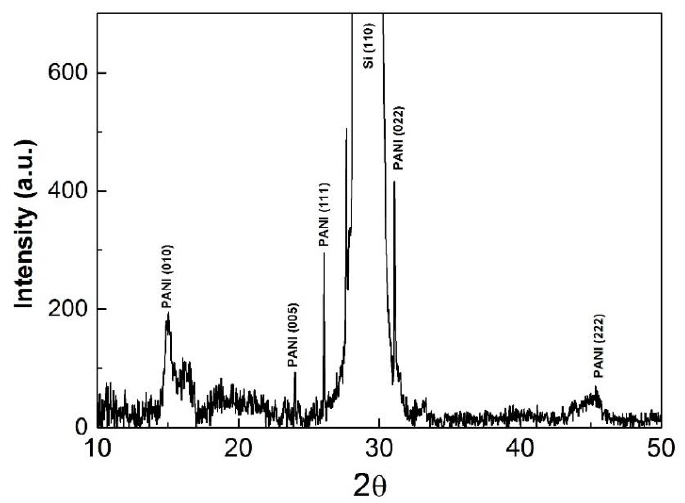
Figure 10. XRD diffraction patterns of the PANI 8 sample.